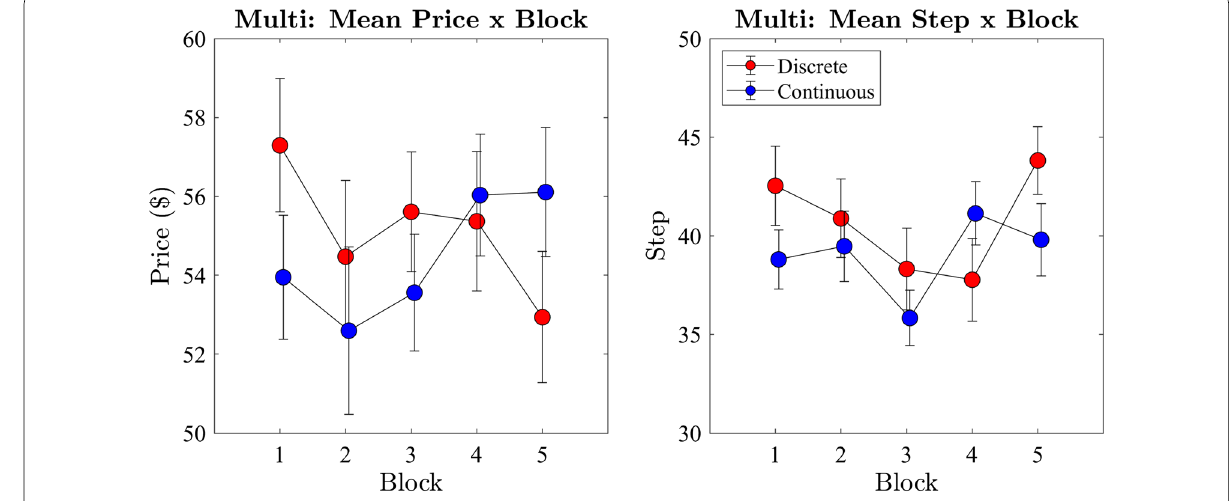
Fig. 12 Exp 2: mean price and step of winning bids per block